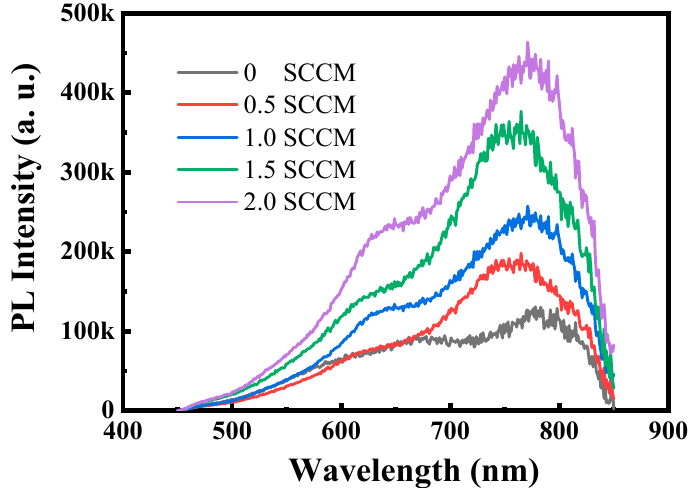
Figure 1. PL spectra of thin films prepared at different NH 3 flow rates under an excitation wavelength of 325 nm.